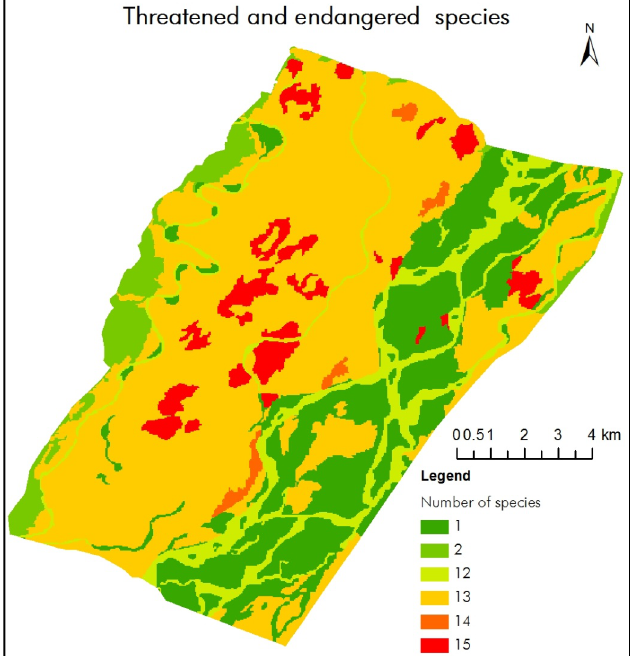
Figure 4. Map showing distribution and habitat use pattern by 20 threatened species in